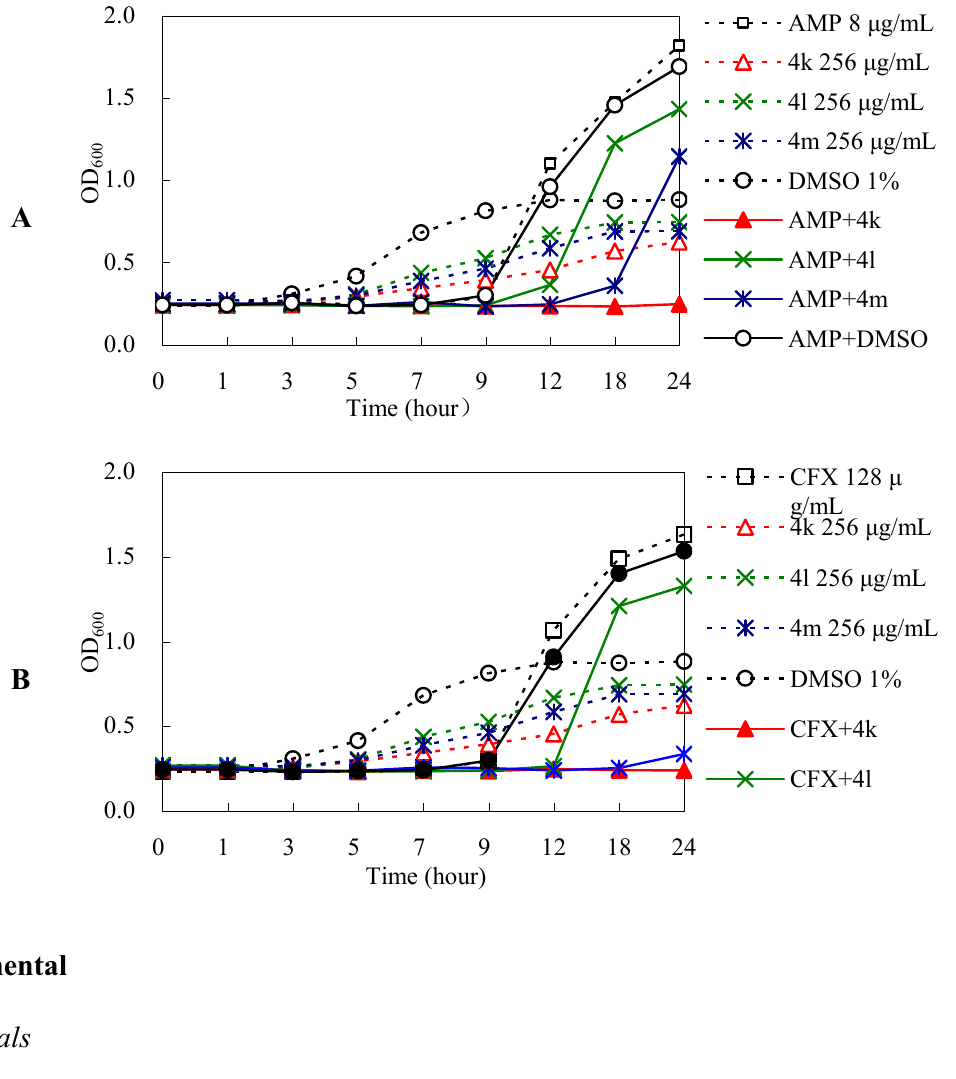
Figure 3. Influence of DHA derivatives on dynamic growth curves of E. coli AG100A/pET28a-AcrB. The bacteria from the exponential phase of growth were diluted with LB broth to 1.0 × 10 6 cfu/mL. Indicated concentrations of DHA derivatives and antibiotics (1/2 MIC) were added into bacterial suspension. Bacterial growth was at regular intervals. AMP, ampicillin; CFX, cefuroxime; determined by measuring OD 600 4k , 4l , and 4m , DHA derivatives (256 μ g/mL, <1/2 MIC) in combinations with AMP (8 μ g/mL, 1/2 MIC) or CFX (128 μ g/mL, 1/2 MIC). Representative data from one of three independent experiments are shown; the standard deviation bars are not